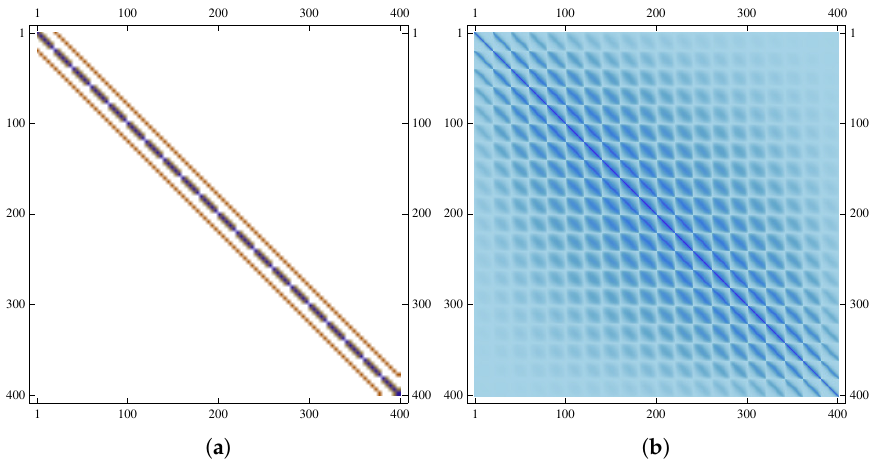
Figure 8. Representation of the ( a ) matrix and ( b ) inverse matrix for Example (6) ( b ) when p = q =